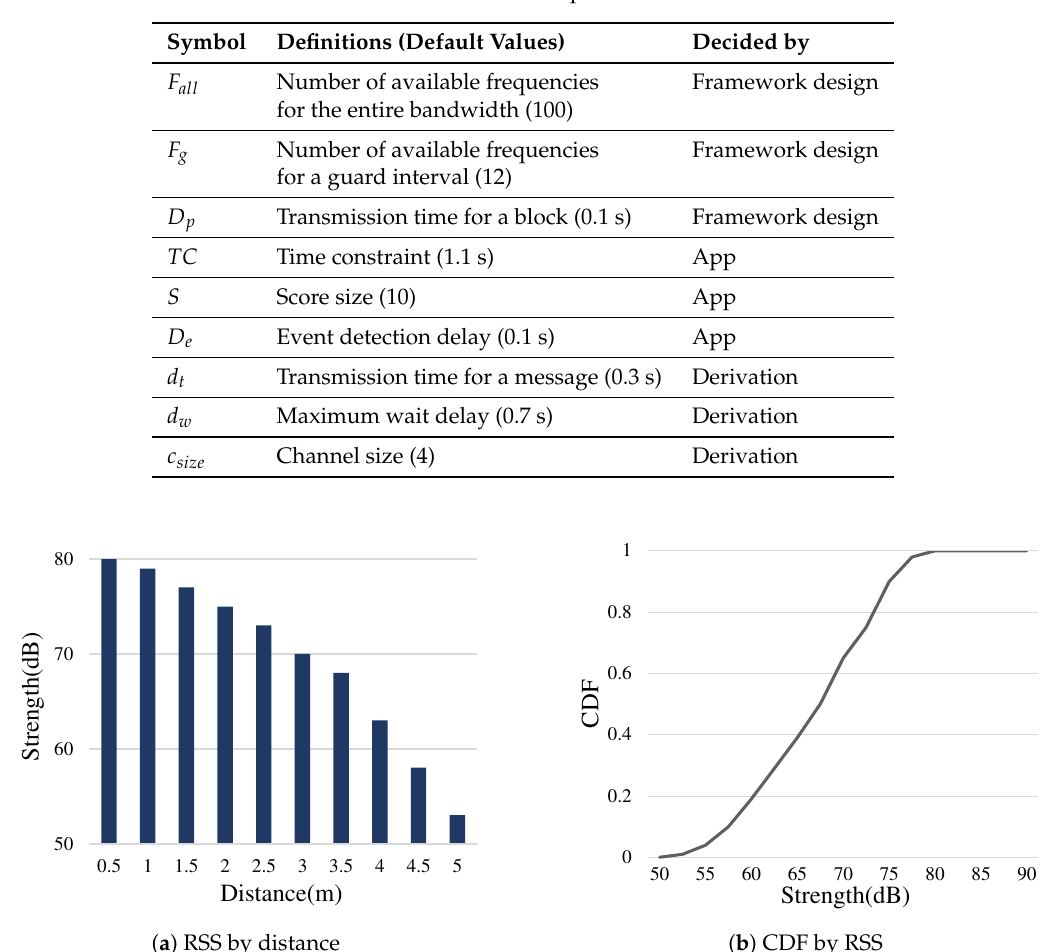
Table 1. Framework parameters.